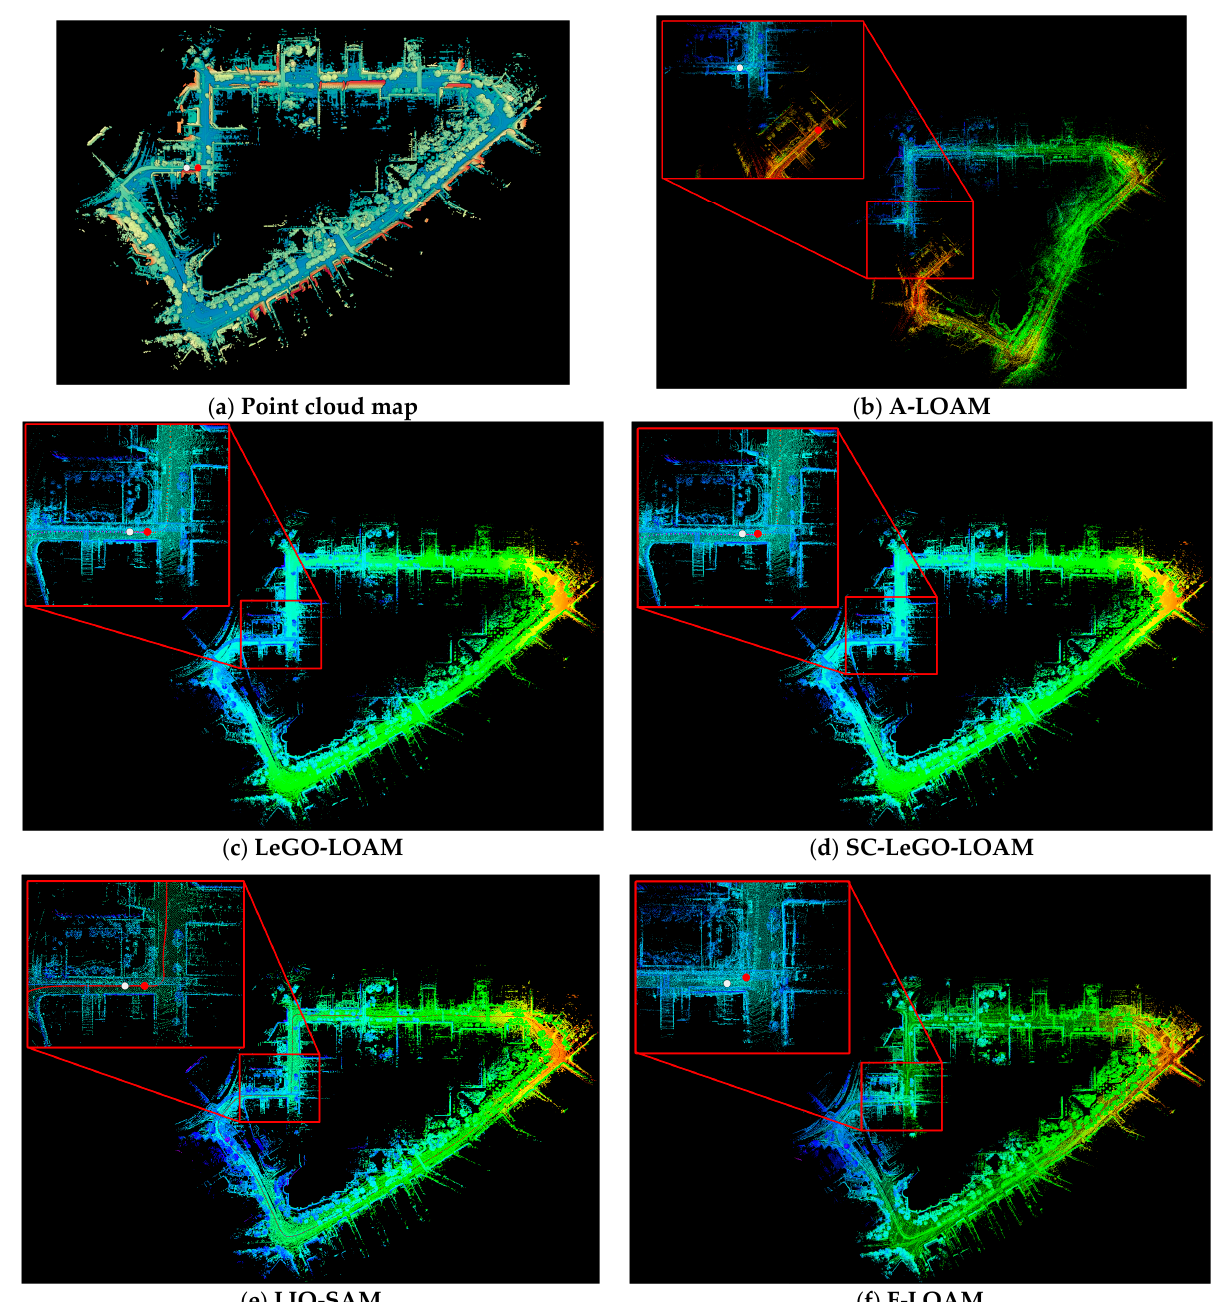
Figure 9. Point cloud maps generated by different algorithms. ( a ) The actual point cloud map given by the dataset. ( b ) Result of A-LOAM. ( c ) Result of LeGO-LOAM. ( d ) Result of SC-LeGO-LOAM. ( e ) Result of LIO-SAM. ( f ) Result of F-LOAM. We zoomed in where the loop was first generated to see the effect of generating the map. The white dots indicate the starting point and the red dots indicate the ending point.